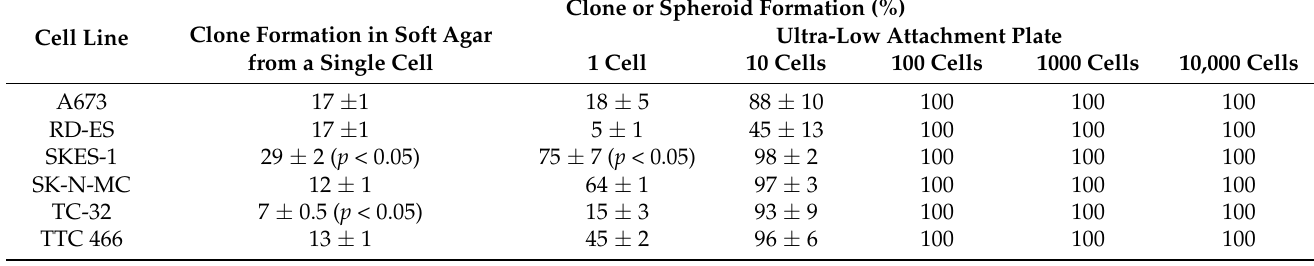
Table 1. Self-renewing ability of ES cell lines. A single cell suspension of each cell line was seeded into soft agar or into a 96 well ultra-low adherence plate at a density of 1–10,000 cells. The number of colonies was counted after 21 days. For studies in soft agar, the mean ( ± SEM) percentage colony formation is expressed as the number of colonies counted at 21 days relative to the number of cells seeded. For cells seeded onto an ultra-low adherence plate, the mean ( ± SEM) percentage colony formation is expressed as the number of wells containing a colony of >5 cells relative to the total number of wells with cells seeded. Results are representative of three independent experiments. Percentage colony formation was compared using ANOVA and Bonferroni’s post hoc test.